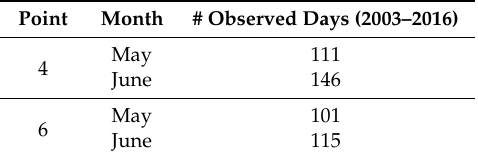
Table 1. Available remote sensing data used to build the baseline since 2003 to